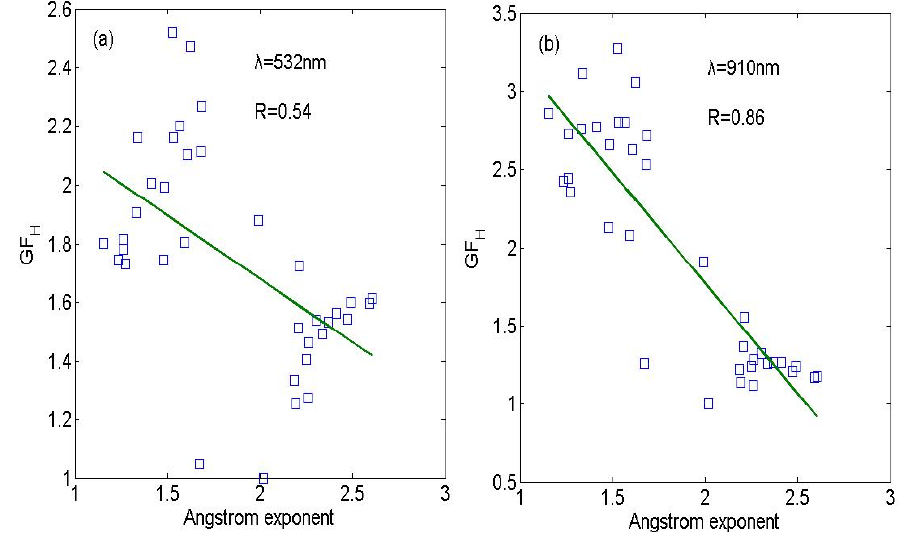
Figure 7. Comparison between hygroscopic growth factor and Angstrom exponent at ( a ) 532 nm and ( b ) 910 nm.